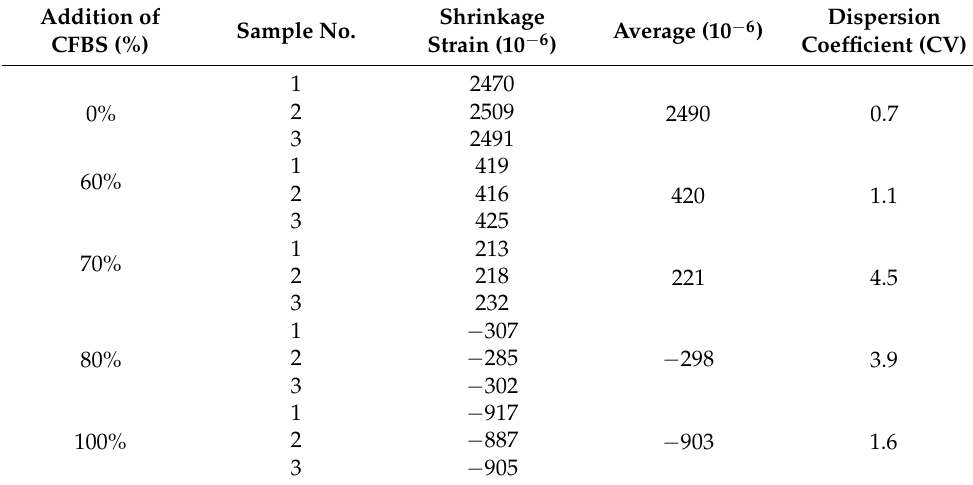
Table 4. The shrinkage strain, average value of shrinkage strain, and coefficient of variation for the samples on the 40th day of the test.